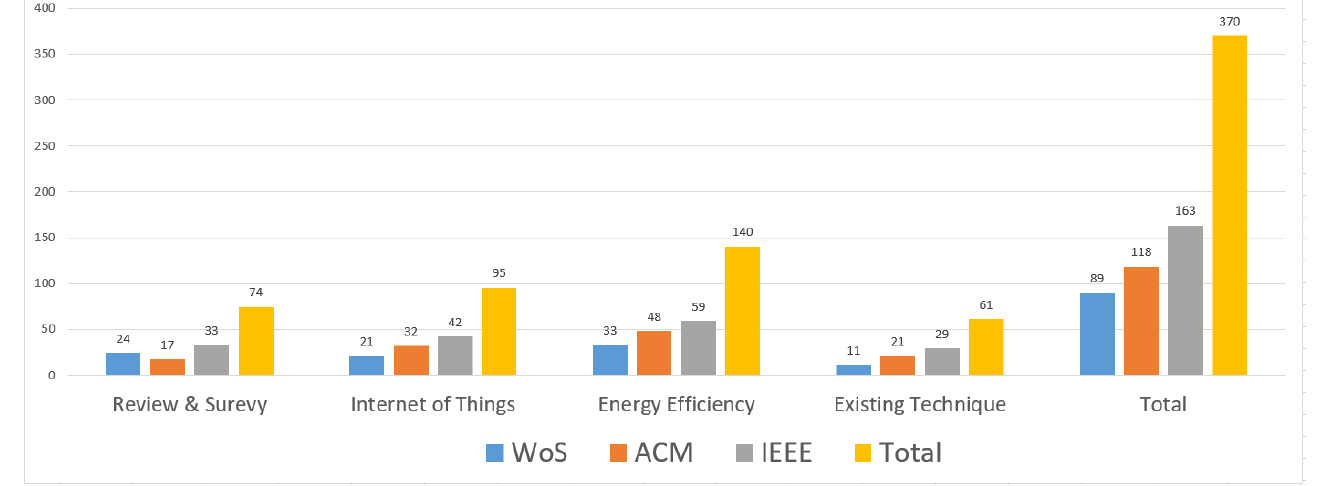
Version August 13, 2021 submitted to Journal Not Specified Figure 3. Articles categorized based on their contribution Figure 3. Articles categorized based on their contribution.